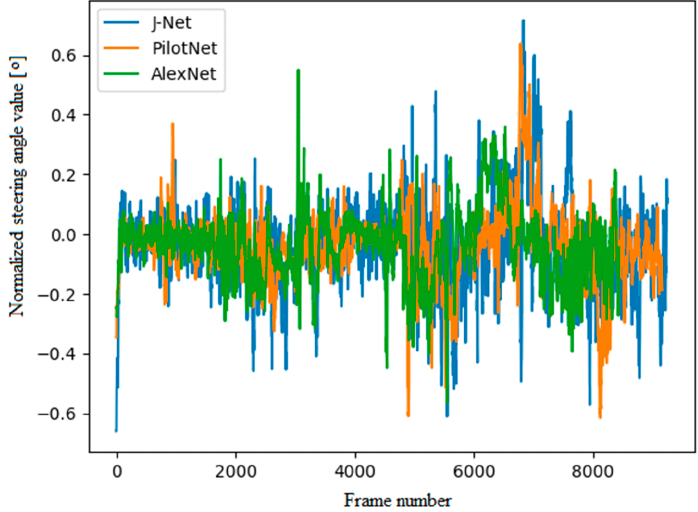
Figure 16. Steering angle predictions used for autonomous driving, presented as normalized absolute values of steering angle in degrees. J-Net has a blue plot, PilotNet orange, and AlexNet green.